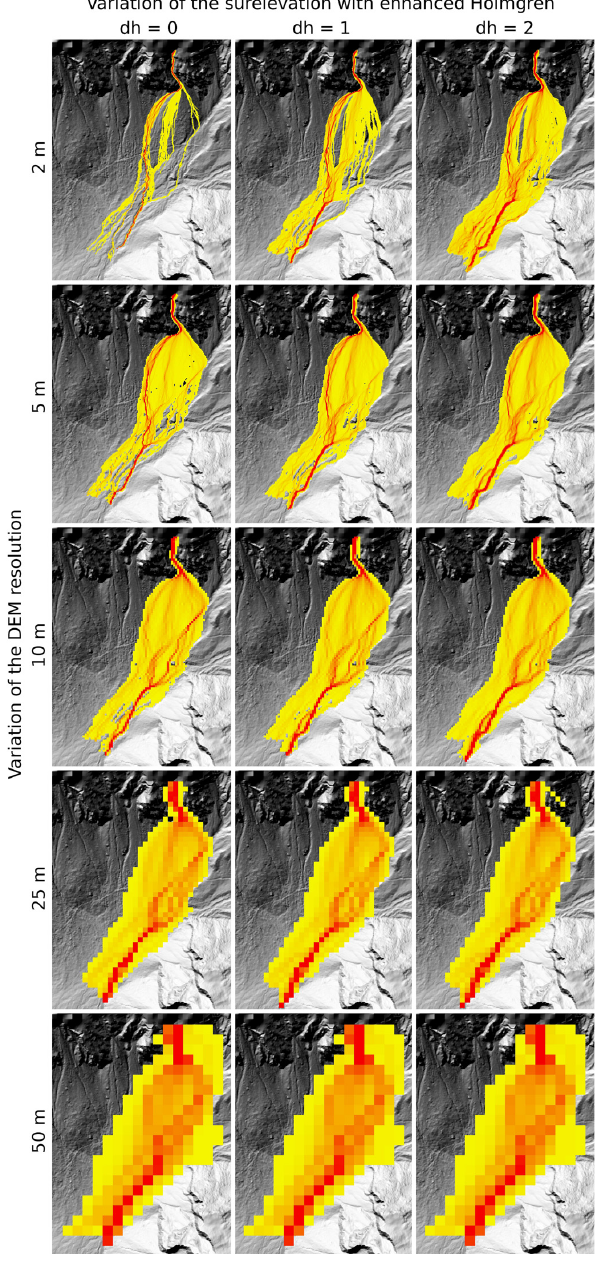
Fig. 10. Effect of the DEM resolution and the modification of Holm- gren’s spreading algorithm on a debris flow fan in Solalex, Switzer- land (Geodata ©swisstopo –